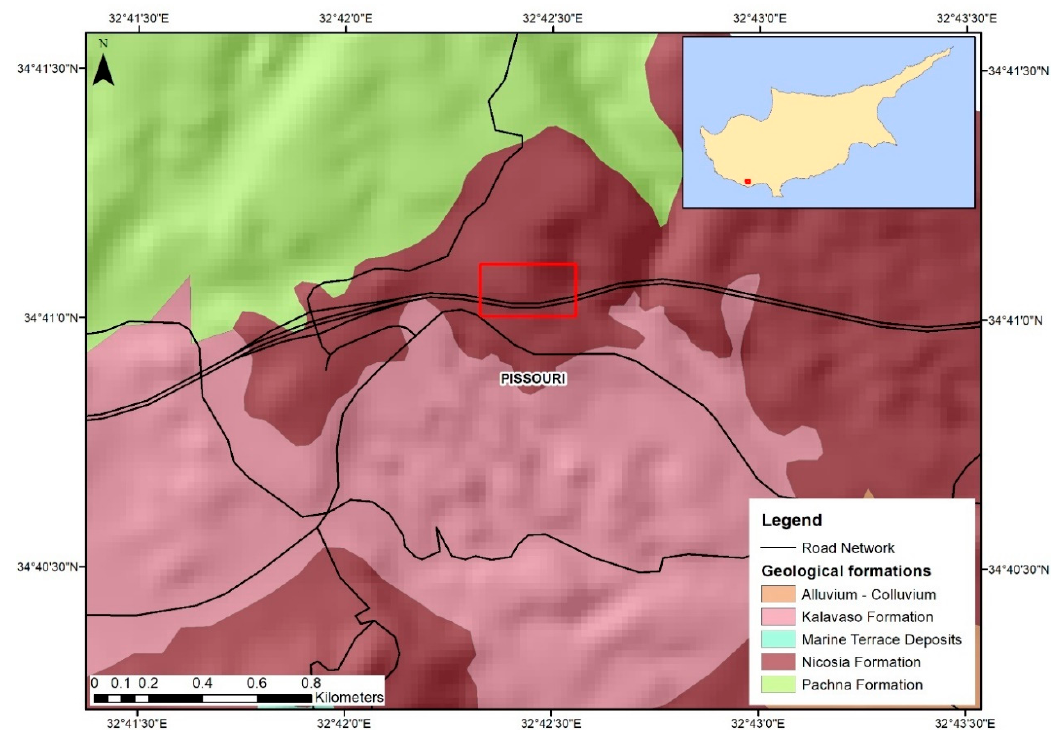
Figure 5. The geology of the wider area surrounding the case study near Pissouri.